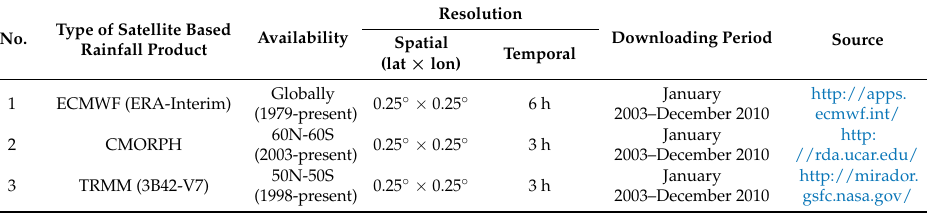
Table 3. Satellite-based and reanalysis products used in this